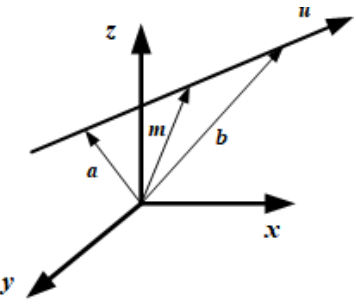
Figure 1. Plücker coordinates of the